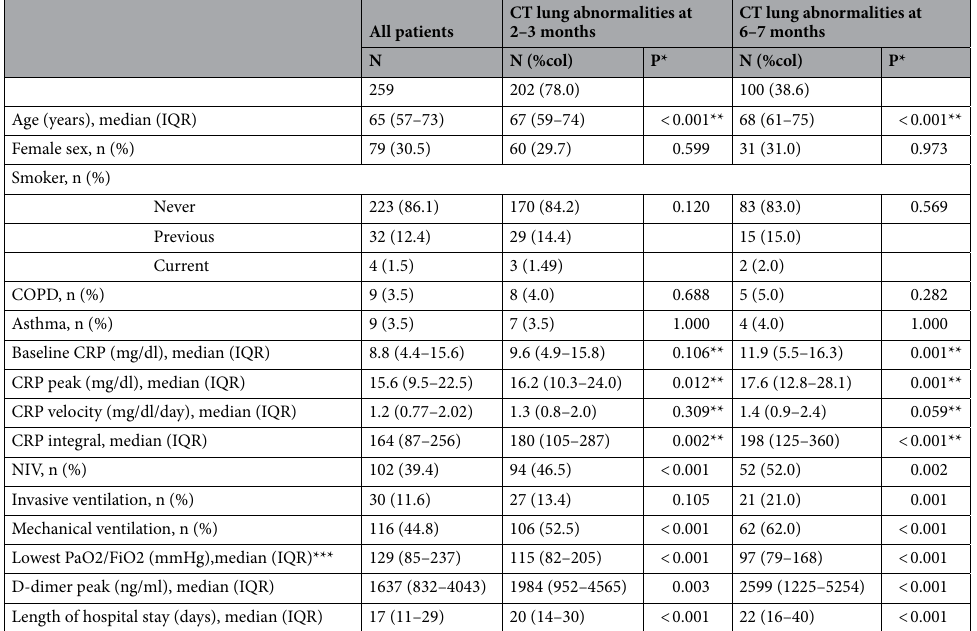
Table 1. Baseline putative determinants of CT lung abnormalities during follow-up in the whole cohort, and only in patients with CT lung abnormalities at 2–3 and at 6–7 months. IQR, interquartile range; COPD, chronic obstructive pulmonary disease; CRP, C-reactive protein; NIV, non-invasive ventilation; PaO2, arterial partial pressure of oxygen; FiO2, inspiratory fraction of oxygen. Mechanical ventilation refers to invasive and/ or non-invasive mechanical ventilation. * Pearson’s chi-squared test or Fisher exact test and p-value for the hypothesis of independence in the two-way table; ** p-value for non-parametric equality-of-medians test; *** PaO2/FiO2 was not available (missing value) for 12